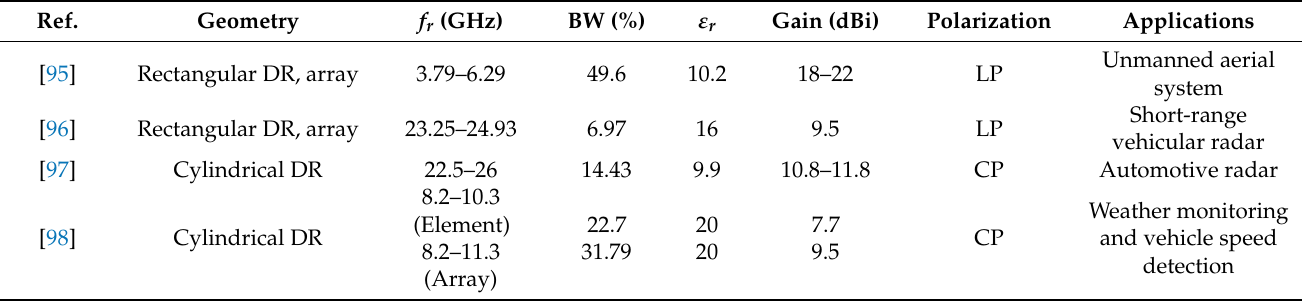
Table 9. Comparison between various DRAs for radar